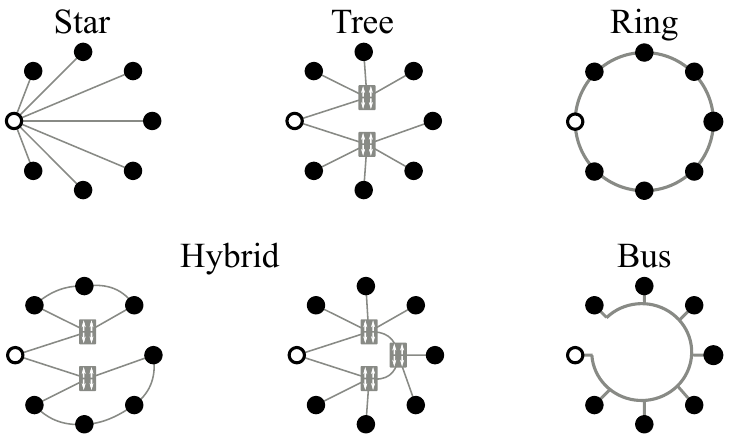
Figure 1. Network topologies. The small white dots represent the master node and the black dots the